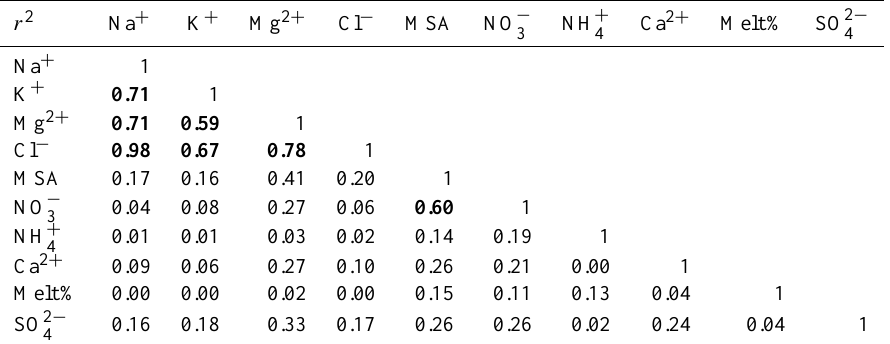
NH + Ca 2 + Melt% SO 2 − 3 4 4